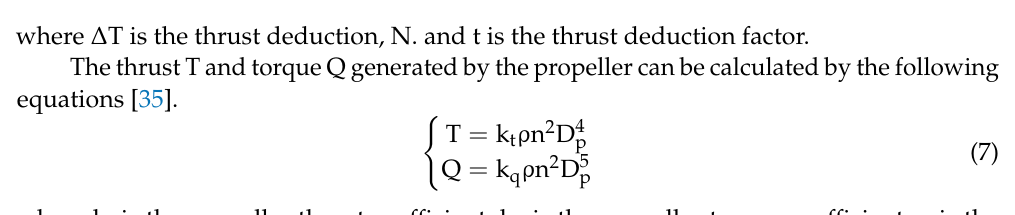
Table 2. Part of the verification data.